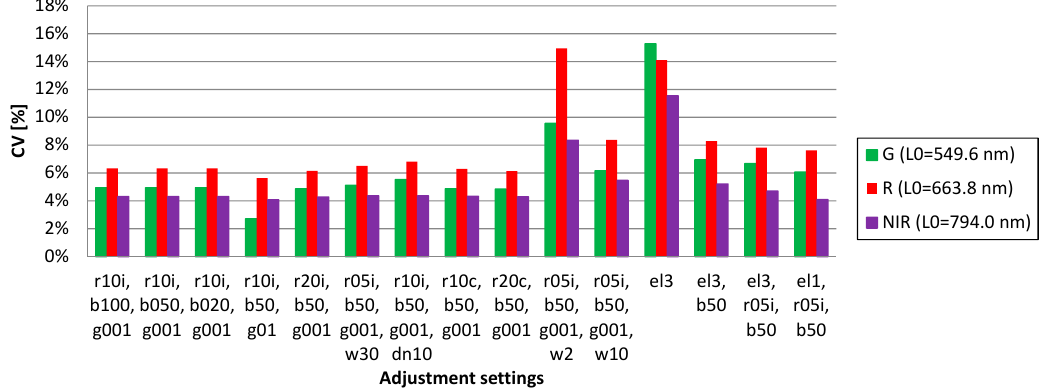
Figure 9. Mosaic homogeneity evaluation using coefficient-of-variation (CV) of radiometric tie points after adjustment for bands green (L0 = 549.6 nm), red (L0 = 663.8 nm) and NIR (L0 = 794.0 nm). Weighting and a priori value settings: r05i, r10i, r20i: (cid:2026) (cid:3028)_(cid:3045)(cid:3032)(cid:3039) = 0.05, 0.1 and 0.2, respectively, a priori values: Intersil irradiance; r10c, r20c: (cid:2026) (cid:3028)_(cid:3045)(cid:3032)(cid:3039) : 0.1 and 0.2, respectively, a priori values: 1.0; b100, b50, b20: (cid:2026) (cid:3003)(cid:3019)(cid:3005)(cid:3007) 100%, 50% and 20% of a priori values; g001, g01: (cid:2026) (cid:3019)(cid:3004)(cid:3017) = 0.001 and 0.01, respectively; dn10: (cid:2026) (cid:3005)(cid:3015) = 0.10, in other cases (cid:2026) (cid:3005)(cid:3015) = 0.05; w2, w10, w30: tie point window size 2 × 2, 10 × 10 and 30 × 30 pixels, respectively (if not marked, 30 × 30 pixels). el3: Empirical line model for flights f1, f2 and f34;